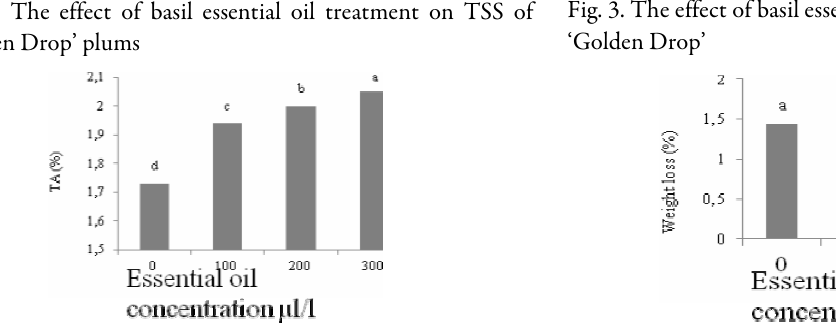
Fig. 2. The effect of basil essential oil treatment on TA of ‘Golden Drop’ plums